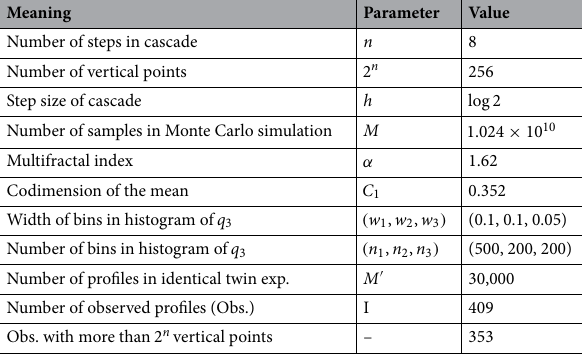
γ , γ − γ , γ − γ ♯ ) . ( a ) (cid:31) (cid:31) (cid:30) (cid:31)